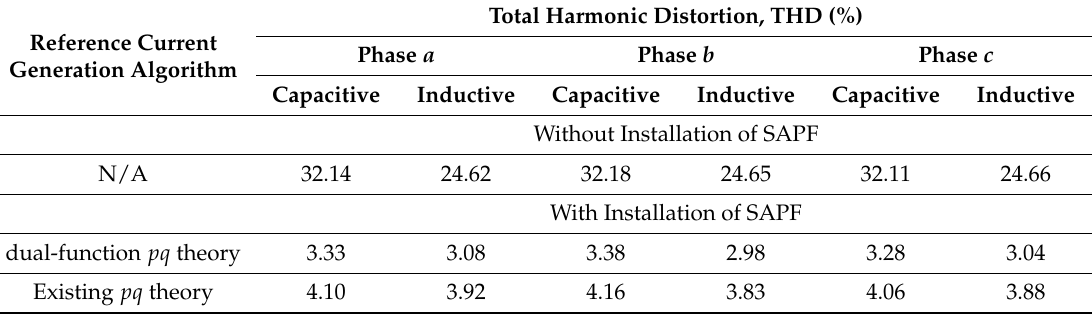
Table 2. Experimental result showing THD values of source current demonstrated by SAPF while applying its respective reference current generation algorithm, for capacitive and inductive loads.